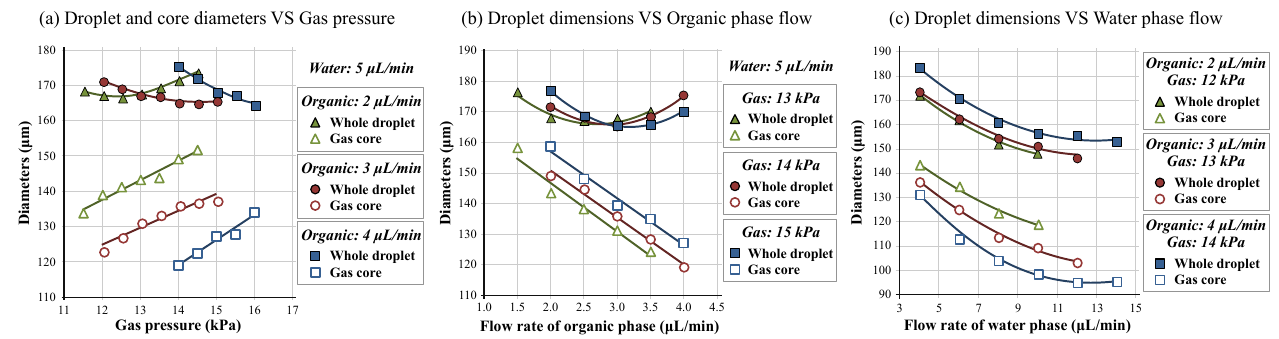
Figure 4. Results of the multiphase droplet generation that occurred by controlling the flow rate of each phase fluid. ( a ) Droplet and core diameters vs . gas pressure; ( b ) droplet dimensions vs . organic phase flow; ( c ) droplet dimensions vs . water phase